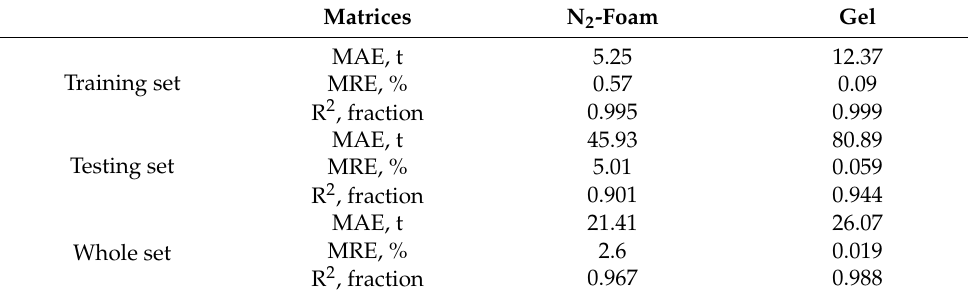
Figure 6. Cross plots of the true and prediction profile control oil increment using the XGBoost for the ( a ) N2 ‐ form and ( b ) gel. Table 6. Summary of the evaluation matrices for N2 ‐ foam and gel.